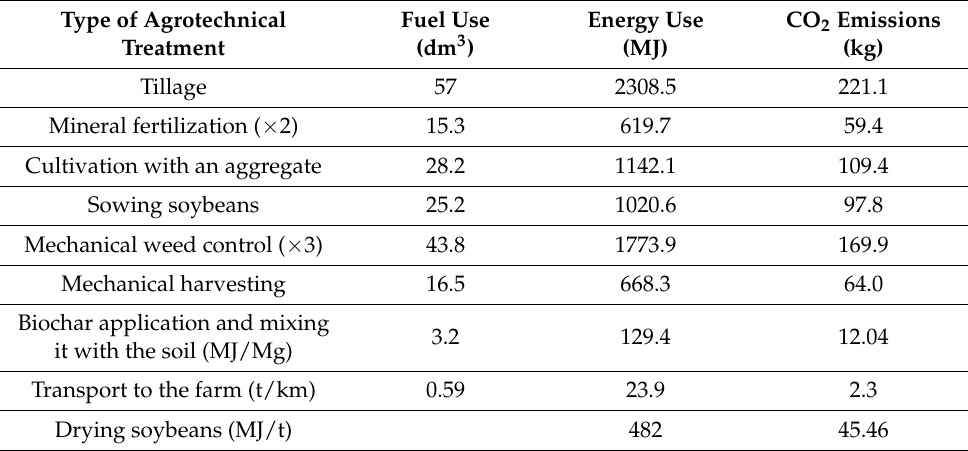
Table 3. Energy consumption and GHG emissions related to agricultural treatments.